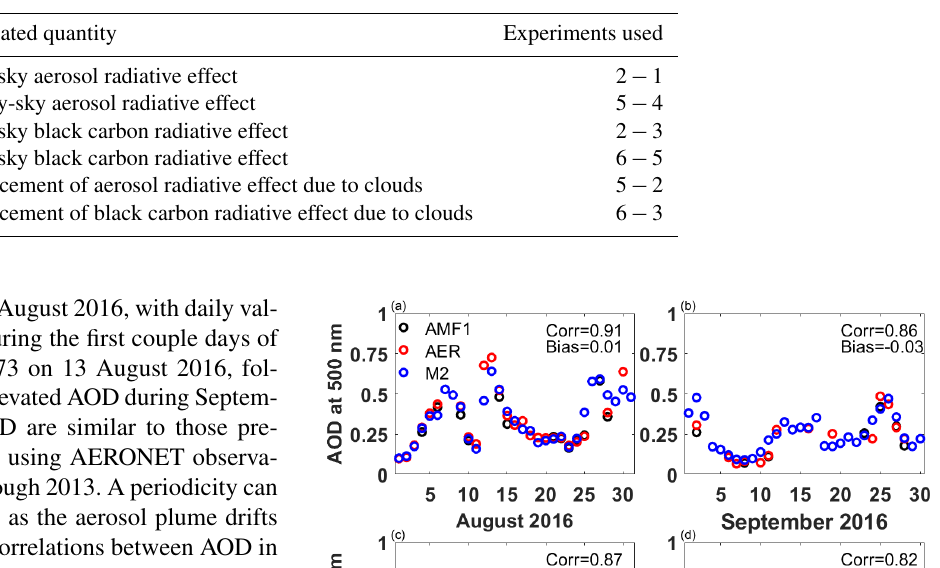
Table 2. Quantities calculated using the radiation transfer experiments and methods for their calculation using the numbered experiments in Table 1.